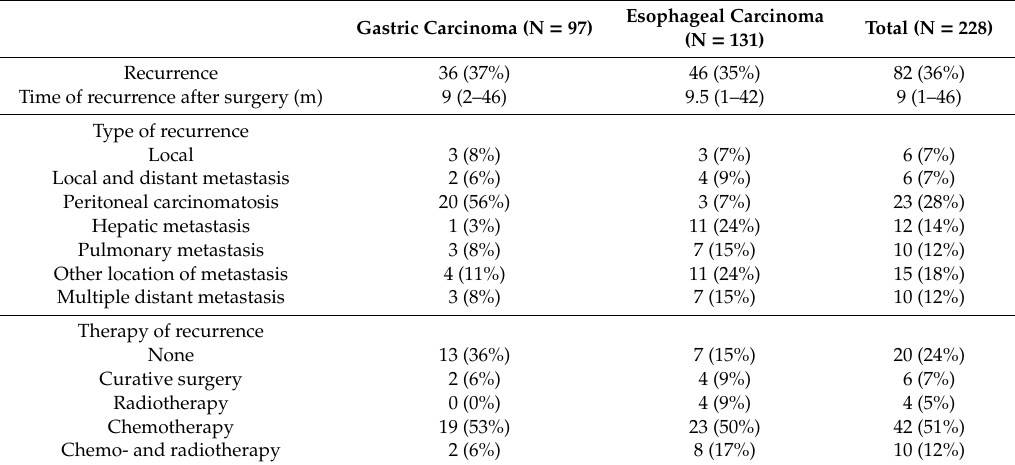
Table 2. Pattern of